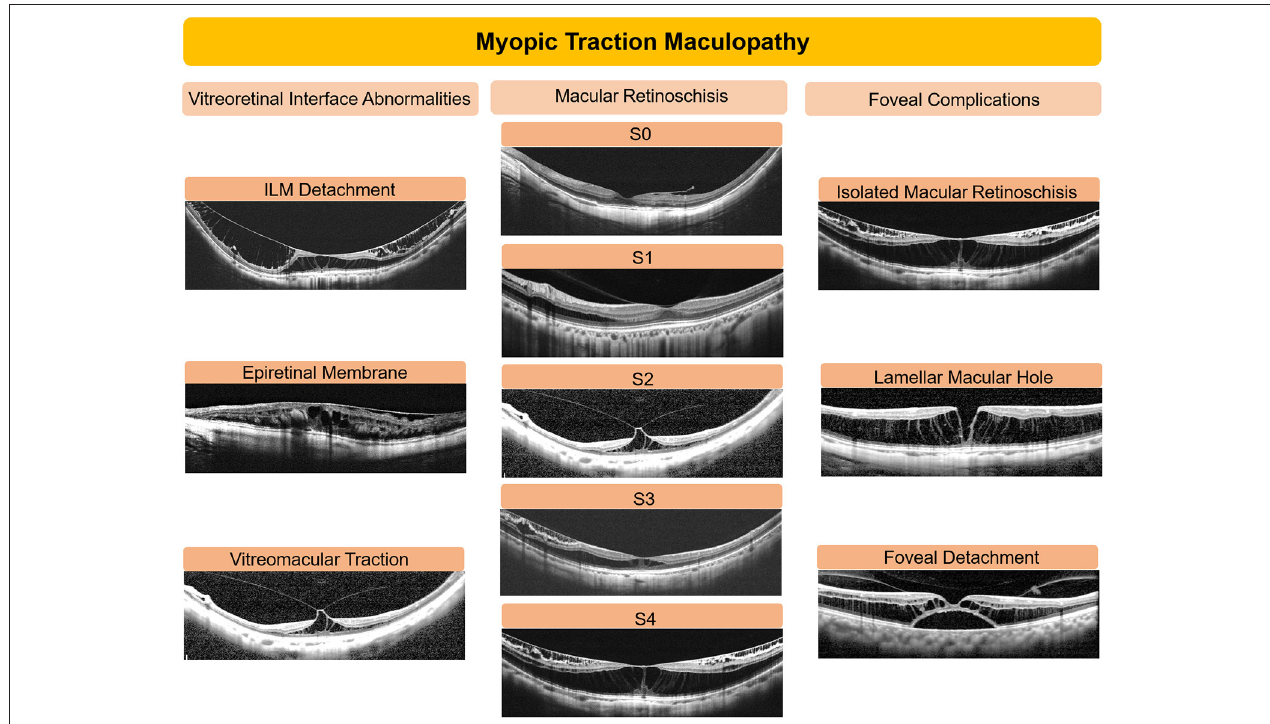
FIGURE 1 | Representative images of optical coherence tomography (OCT) in eyes with myopic traction maculopathy. OCT-based structural changes were comprehensively analyzed based on the vitreoretinal interface abnormalities, degree of retinoschisis, and foveal complications. The outer retinoschisis was graded into 5 levels: no macular retinoschisis (S0), extrafoveal macular retinoschisis (S1), fovea-only macular retinoschisis (S2), foveal but not the entire macular area macular retinoschisis (S3), and entire macular area retinoschisis (S4). Foveal complications included isolated macular retinoschisis without further complications, lamellar macular hole, and foveal detachment. Vitreomacular interface abnormalities included epiretinal membrane, vitreomacular traction, and internal limiting membrane (ILM)